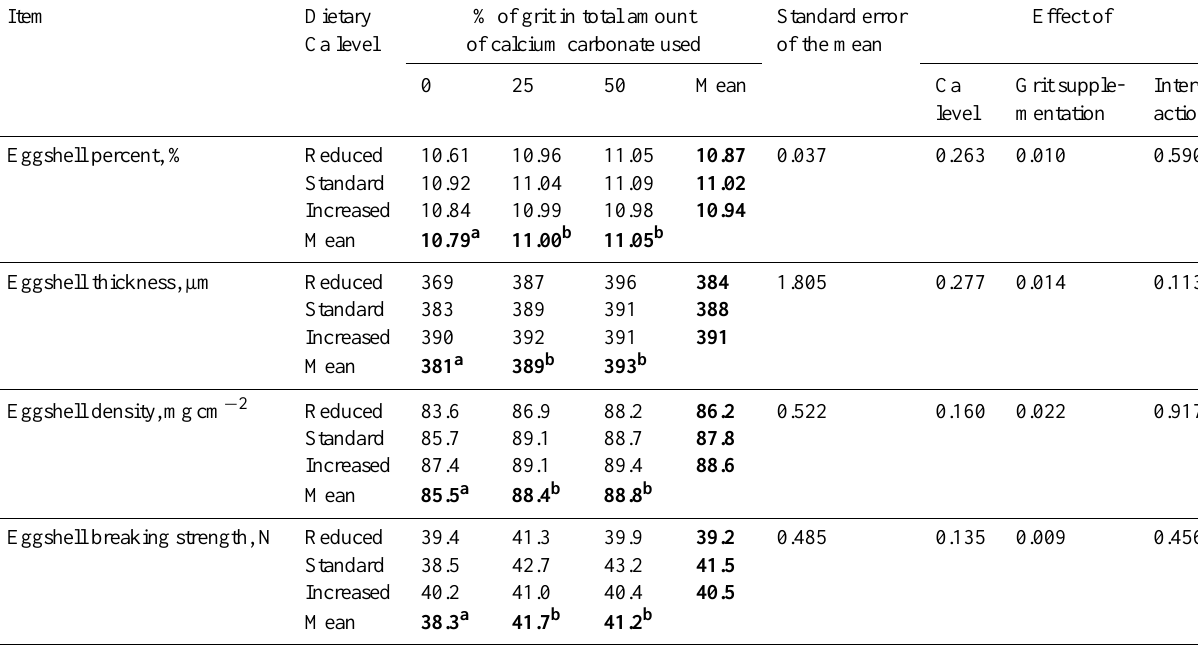
Table 5. Effects of dietary treatments on eggshell quality at 69 weeks of age.